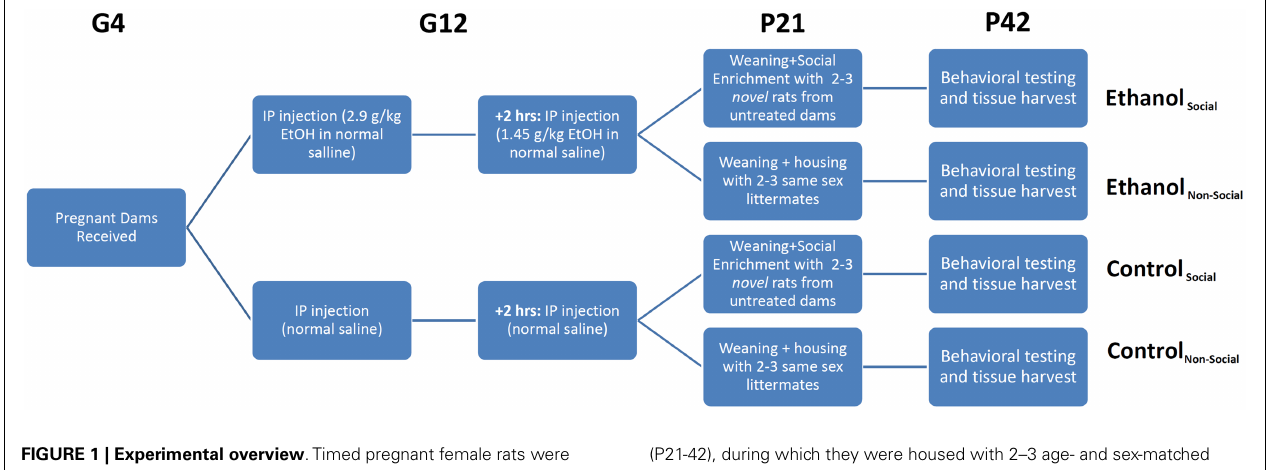
FIGURE 1 | Experimental overview .Timed pregnant female rats were received on gestational day 4 (G4) and split into two treatment groups – ethanol (EtOH) or saline. Each animal was injected twice on G12 with EtOH or an equivalent volume of saline. Pups were delivered in their home cage, litters culled to 10 pups with a 1:1 ratio of males:females, and remained in their home cage until weaning. On weaning, rats were separated into non-social and social-enriched conditions for 3weeks